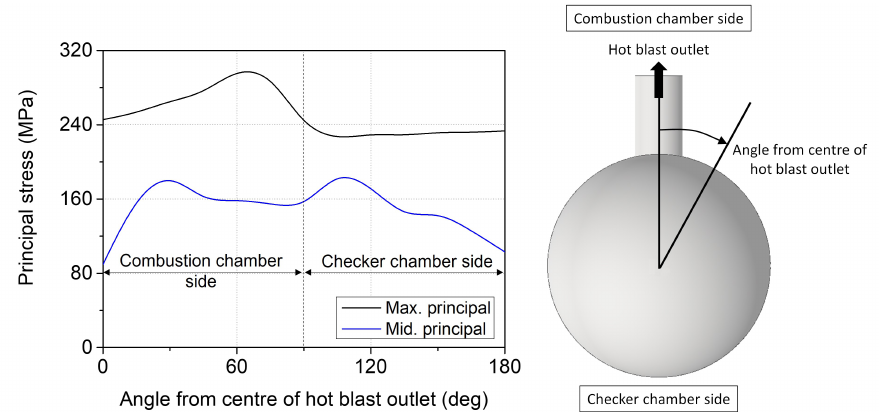
Figure 14. The maximum and middle principal stress of the conical region along the circumferen- tial